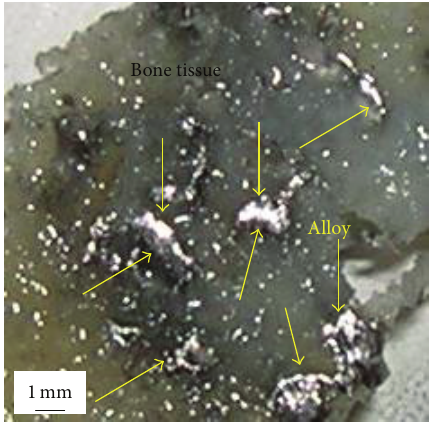
Figure 4: View of the sample in the bone